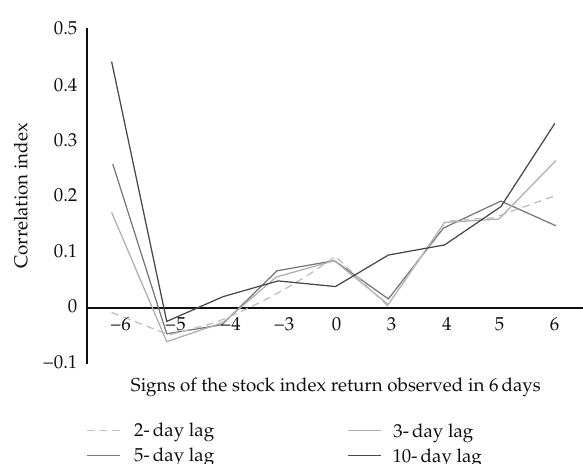
Figure 14: Correlation between the returns of the stock index and the bond